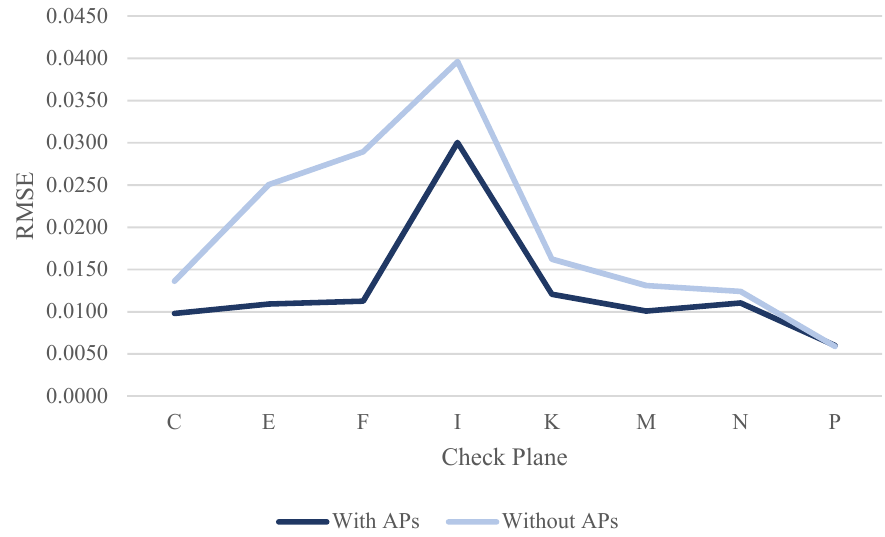
Figure 26. The line chart of RMSE for check planes in dataset DATA2.